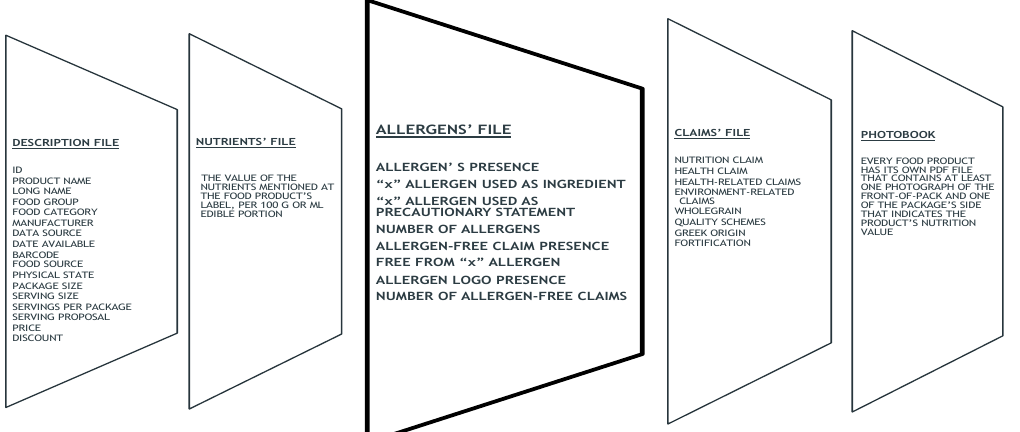
Figure 1. The new structure of the HelTH database. In the newly introduced allergen’s file, “x allergen” refers to any of the 14 allergens mentioned at the EU regulation [28] (cereals containing gluten (namely wheat, rye, barley, spelt, kamut, or their hybridized strains), crustaceans, eggs, fish, peanuts, soybeans (including soya lecithin), milk (including lactose), nuts (namely almonds, hazelnuts, walnuts, cashews, pecan nuts, Brazil nuts, pistachio nuts, macadamia or Queensland nuts), celery, mustard, sesame seeds, sulphite, lupin, and molluscs, including products thereof). Adapted from Katidi et al. [3].